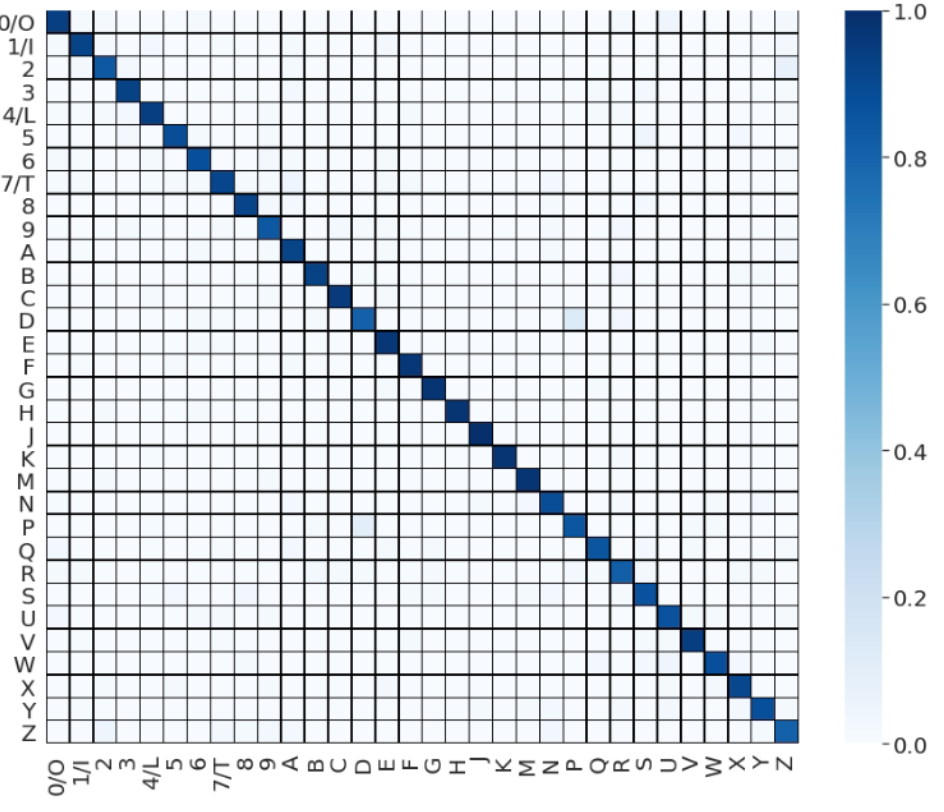
Figure 12. Confusion matrix. Table 3. Accuracies according to the characters.